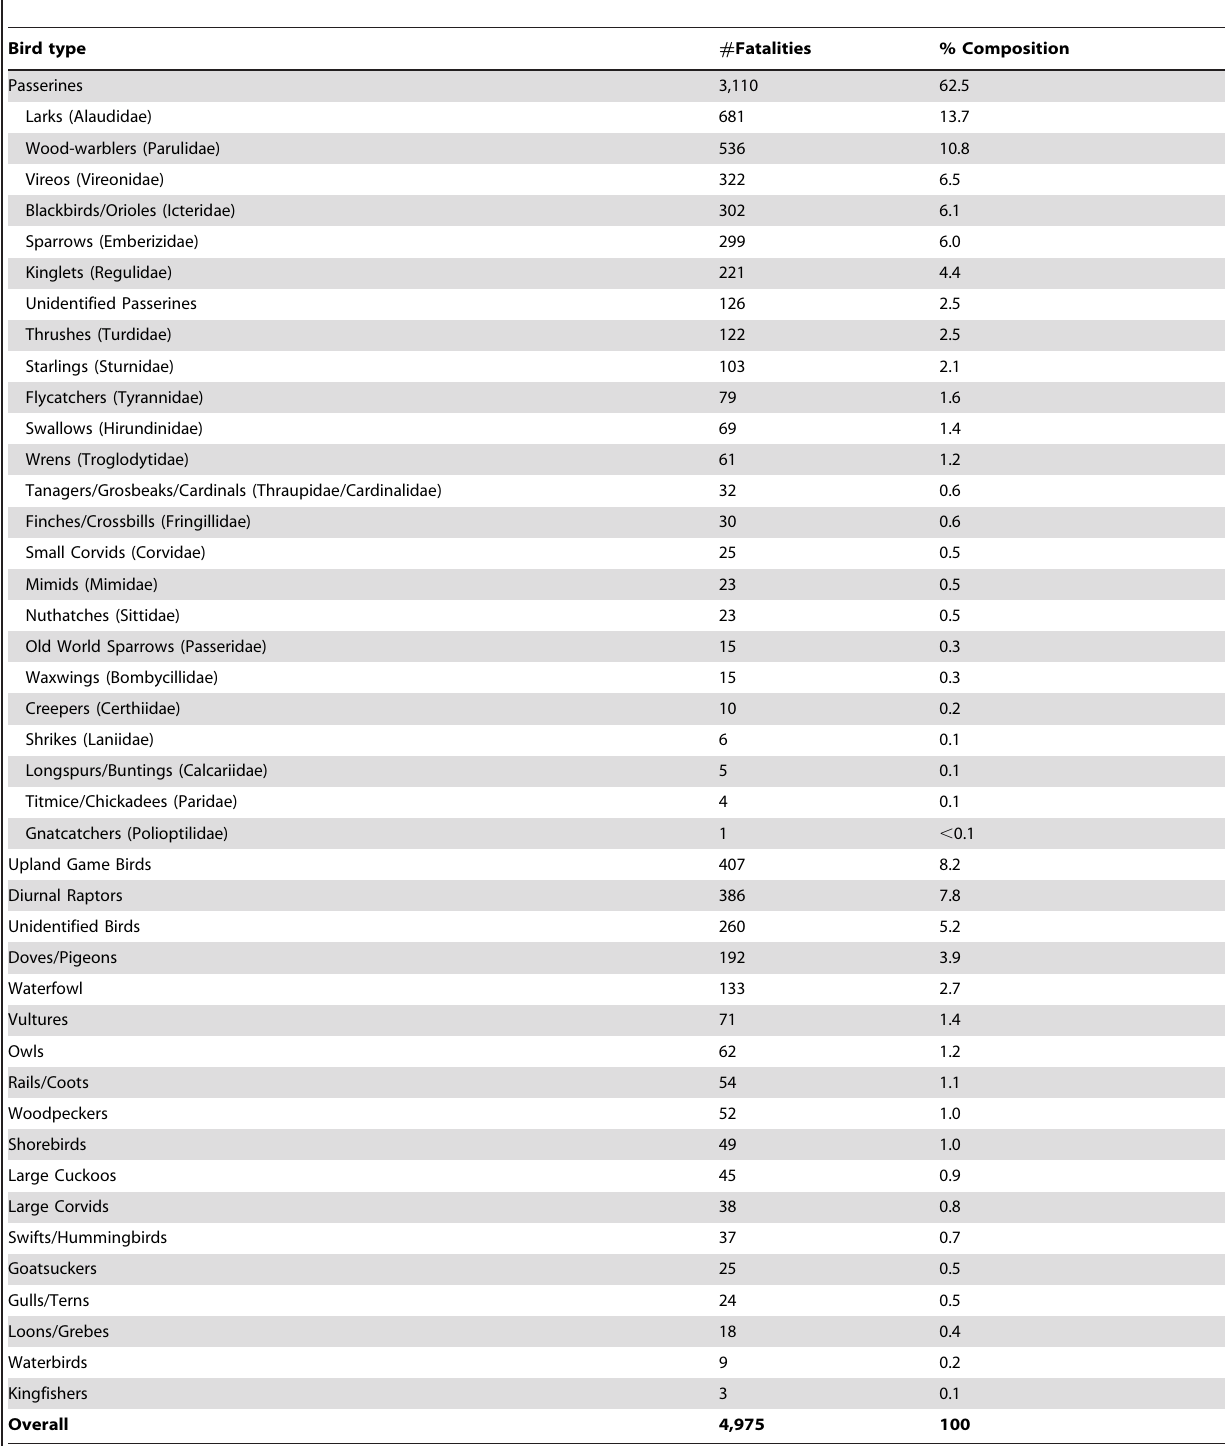
Table 3. Observed number of fatalities (including incidental finds) and percent composition of total for each bird type and passerine sub-type (family) for 116 studies at wind energy facilities in the United States and